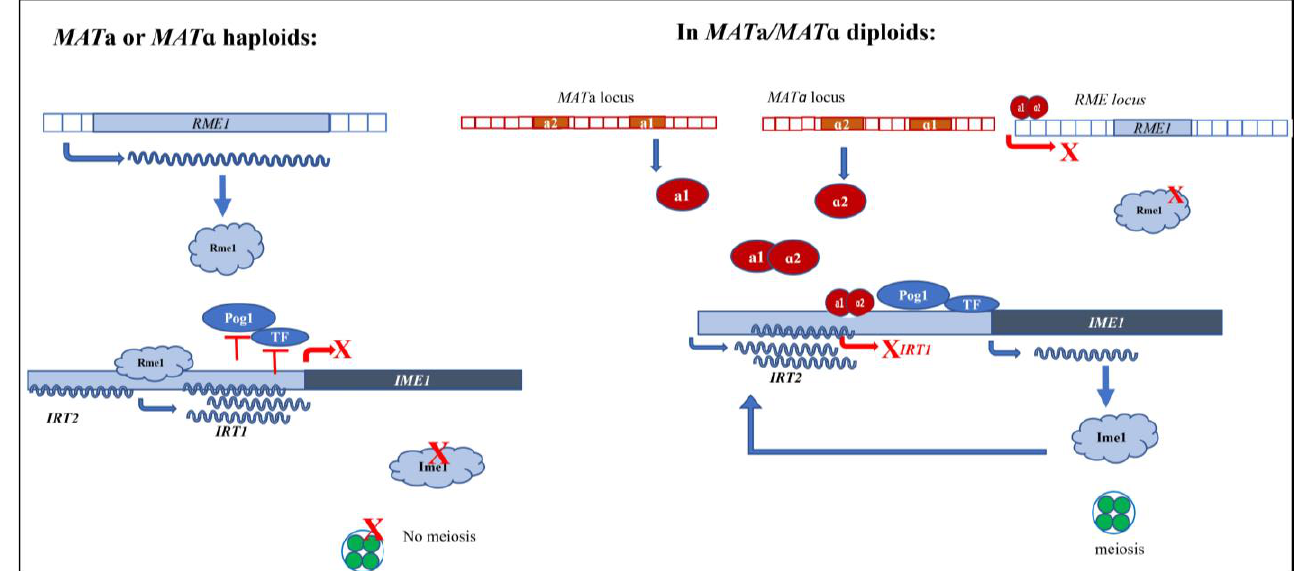
Figure 2. Repression of IME1 and meiosis by lncRNA IRT1 : Rme1 negatively regulates the transcription of IME1, the master regulator of meiosis. Two long non-coding transcripts, IRT1 and IRT2 , arising from the promoter of IME1 , further modulate the expression of Ime1. In haploid cells, basal-level transcription of IRT2 enhances the binding of Rme1 upstream of IRT1 TSS, which activates the transcription of IRT1 . This transcription inhibits the binding of transcription factors, such as Pog1, and also leads to the deposition of repressive chromatin marks. This suppresses the transcription of IME1 . Meanwhile, in diploids, the a1- α 2 repressor complex from MAT loci inhibits transcription of Rme1. Transcription of IRT1 by any leaky Rme1 is prevented by both a1- α 2 repressor binding to Rme1 binding sites in the IME1 promoter and also the transcription of IRT2 . In addition, Ime1 protein also activates its own transcription via IRT2 . This allows the expression of IME1 and progression into meiosis.